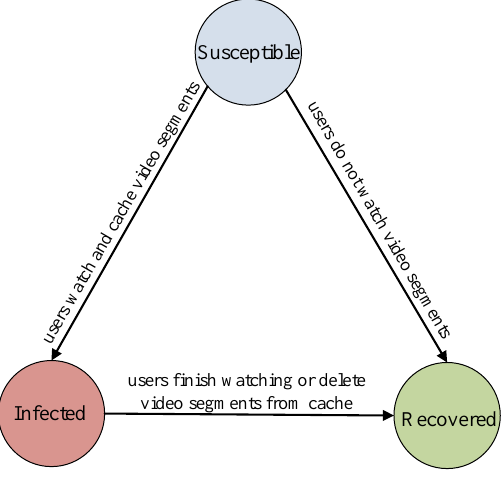
Figure 2: Propagation mechanism based on SIR